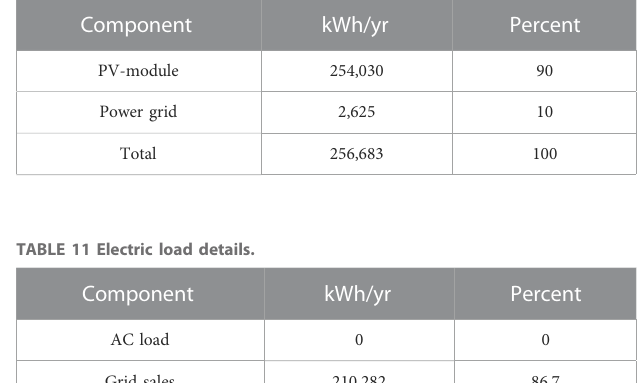
TABLE 10 Power production of PVs and grid.